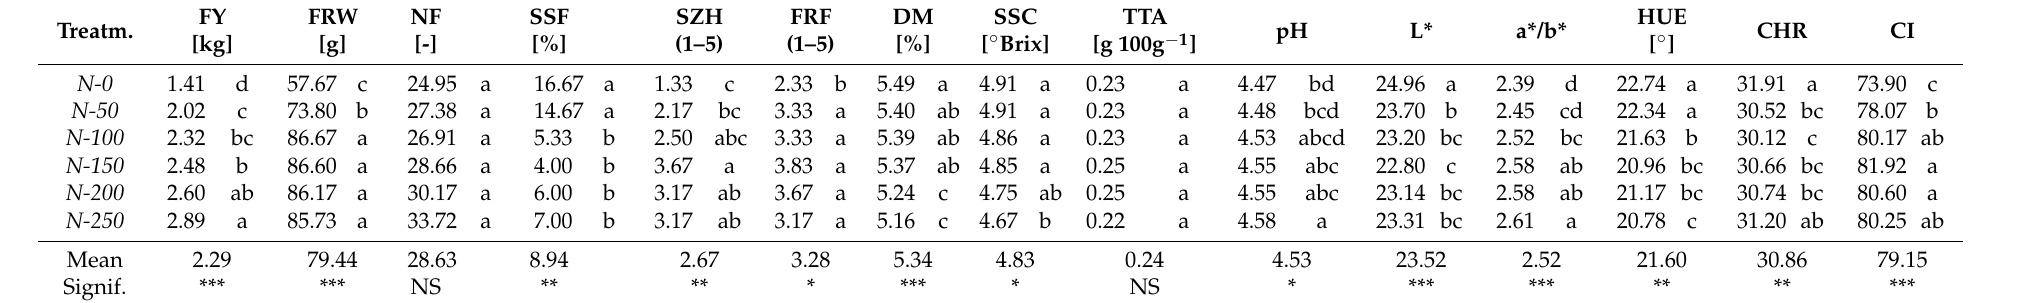
Table 1. Effects of nitrogen fertilization on plant productivity, fruit external appearance, and technological traits of tomato, cv “Messapico”. Treatm.